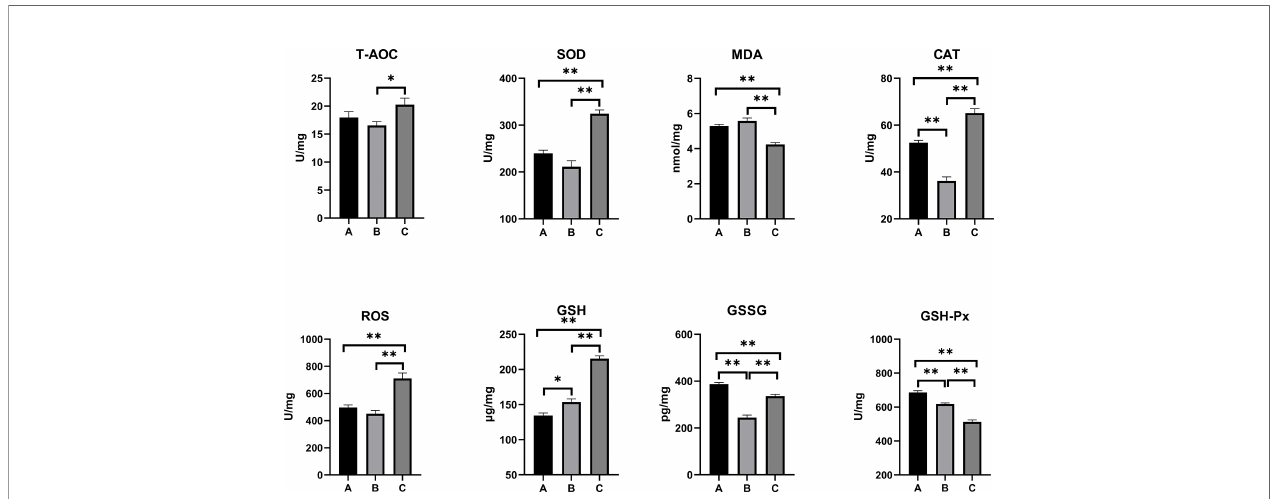
FIGURE 3 | Effects of OTA and AFB1 on kidney oxidative stress and antioxidant status of pullets after 42 days (n = 6, mean ± SEM), including T-AOC, SOD, MDA, CAT, ROS, GSH, GSSG, and GSH-Px. Groups A, B, and C are the control group, the pair-feeding group, and the OTA+AFB1 group, respectively. Data were analyzed with ANOVA and Tukey ’ s HSD, and signi fi cant differences were de fi ned as * p < 0.05 and ** p < 0.01. OTA, ochratoxin A; AFB1, a fl atoxin B1; T-AOC, total antioxidant capacity; SOD, superoxide dismutase; MDA, malondialdehyde; CAT, catalase; ROS, reactive oxygen species; GSH, glutathione; GSSG, oxidized